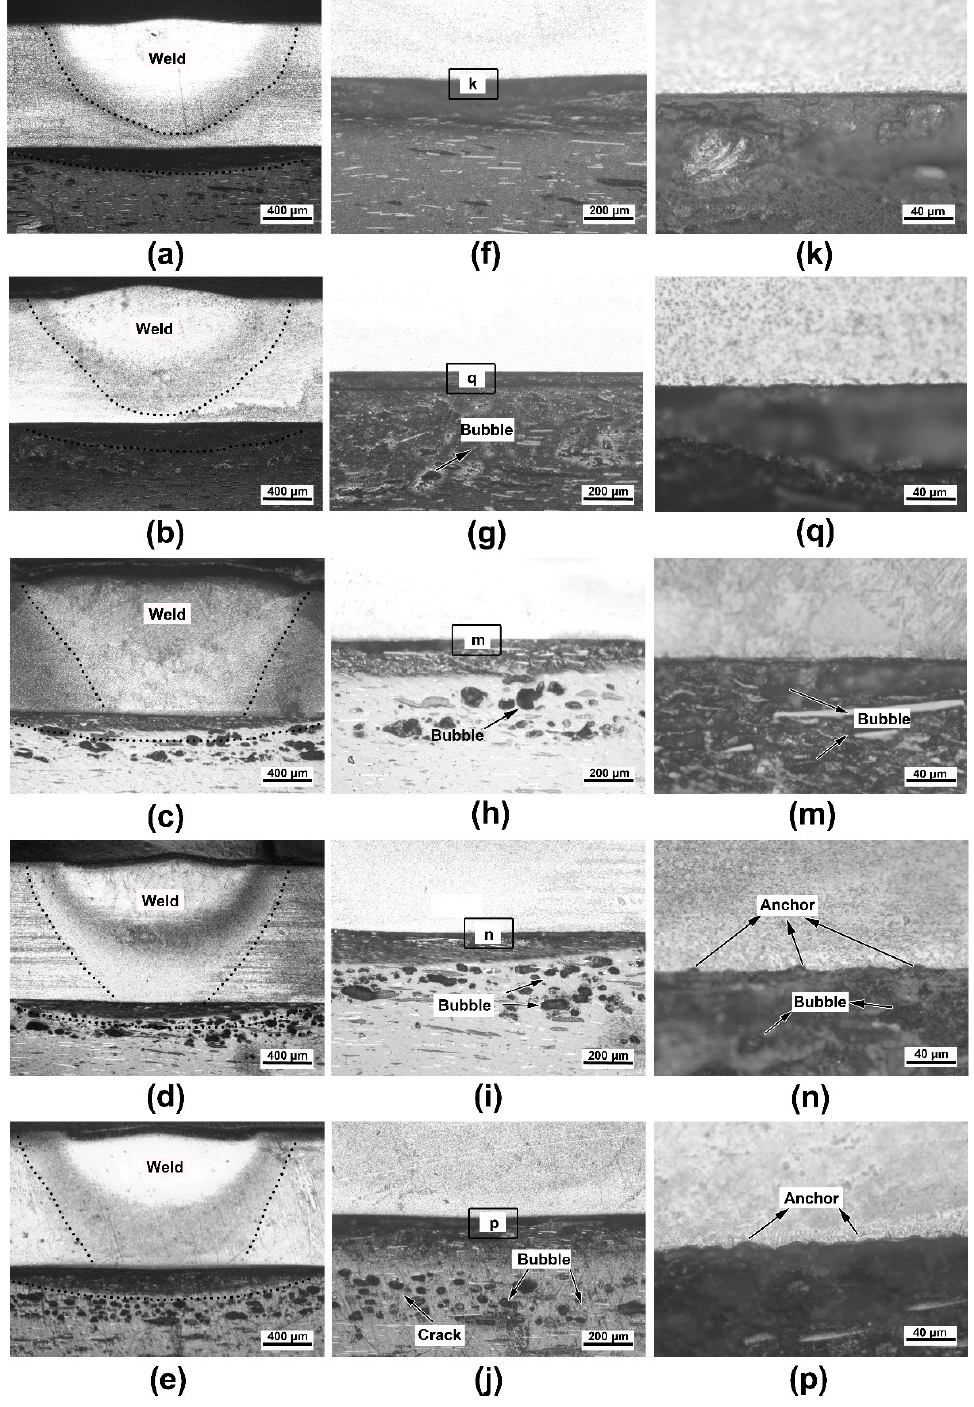
Figure 4. Morphology of joints at speed of ( a ) 16 mm/s, ( b ) 14 mm/s, ( c ) 12 mm/s, ( d ) 10 mm/s and ( e ) 8 mm/s; Details of the joints at speed of ( f ) 16 mm/s, ( g ) 14 mm/s, ( h ) 12 mm/s, ( i ) 10 mm/s and ( j ) 8 mm/s; Interfacial structure of joints at speed of ( k ) 16 mm/s, ( q ) 14 mm/s, ( m ) 12 mm/s, ( n ) 10 mm/s and ( p ) 8 mm/s.